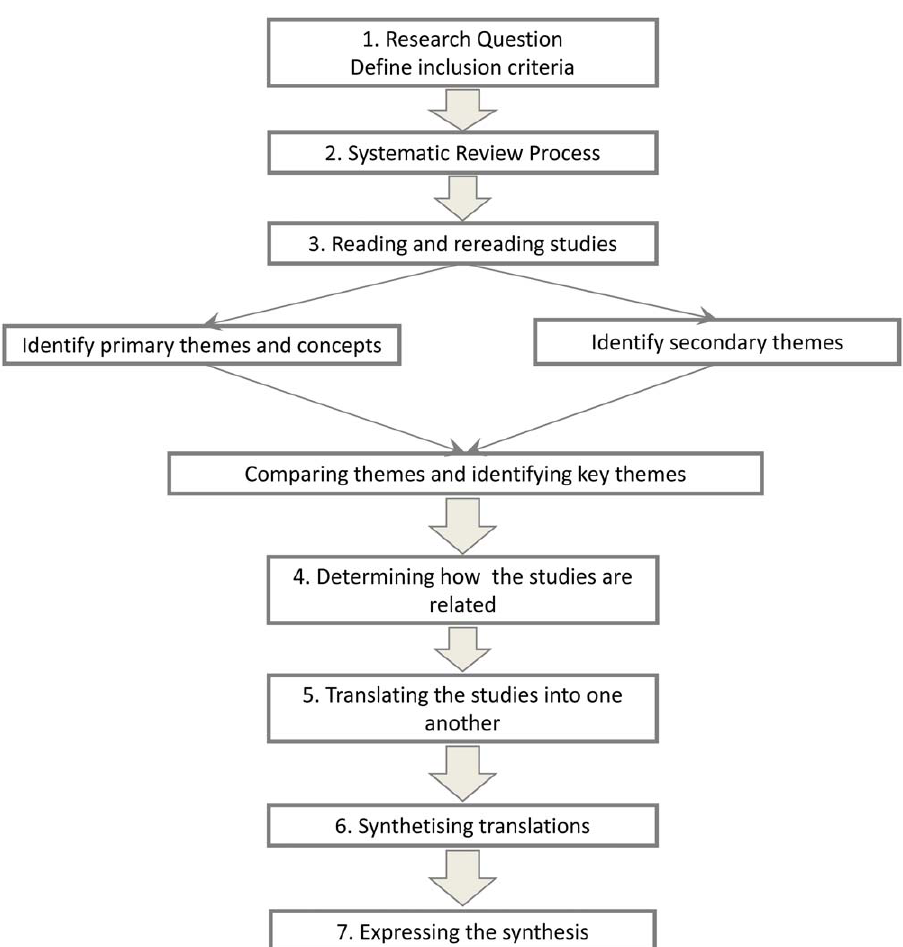
Figure 1. Meta-ethnography process according to Noblit and Hare.